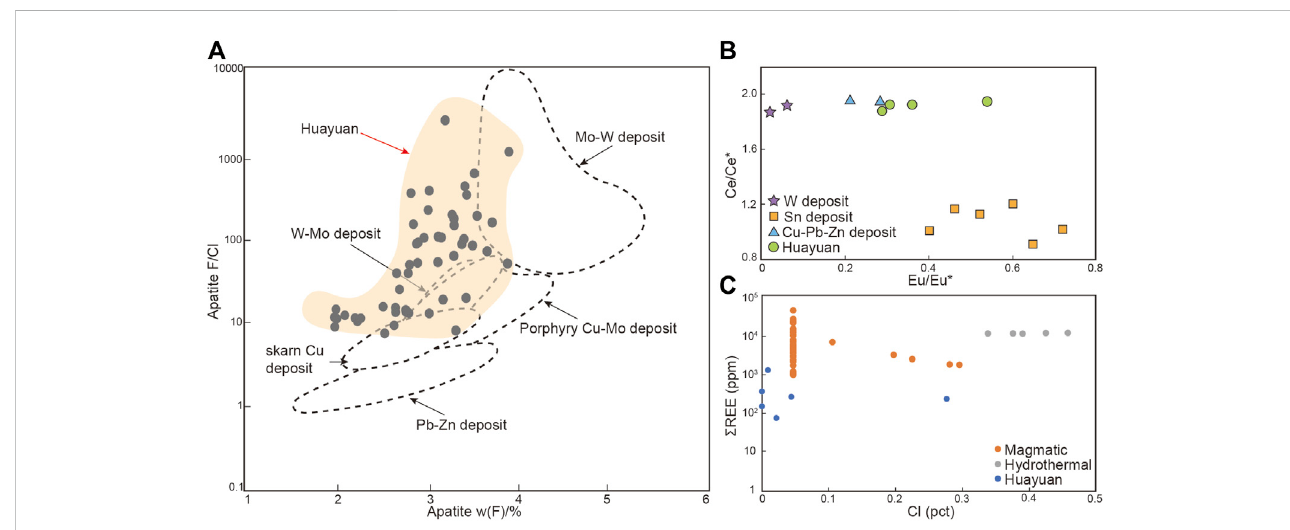
FIGURE 8 Plots of (A) F/Cl vs F (after Cao et al., 2012), (B) Ce/Ce* vs Eu/Eu* (after Ding et al., 2015), and (C) Σ REE vs Cl (data from O ’ Sullivan et al., 2020) for apatite from different types of